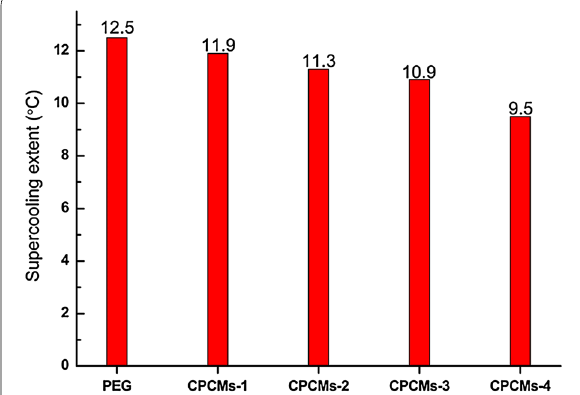
Fig. 11 The degree of supercooling for CPCMs‑1, CPCMs‑2, CPCMs‑3, and